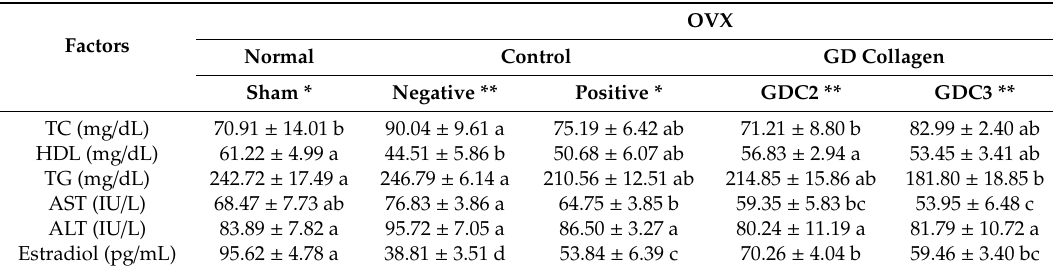
Table 3. Serum biochemical parameters in OVX